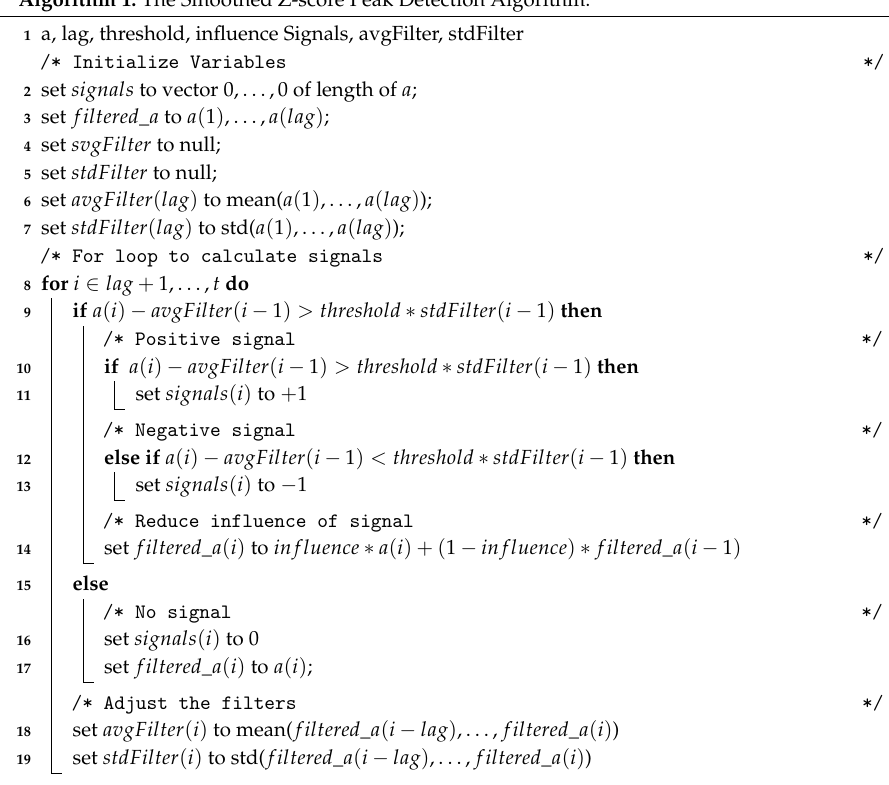
Algorithm 1: The Smoothed Z-score Peak Detection